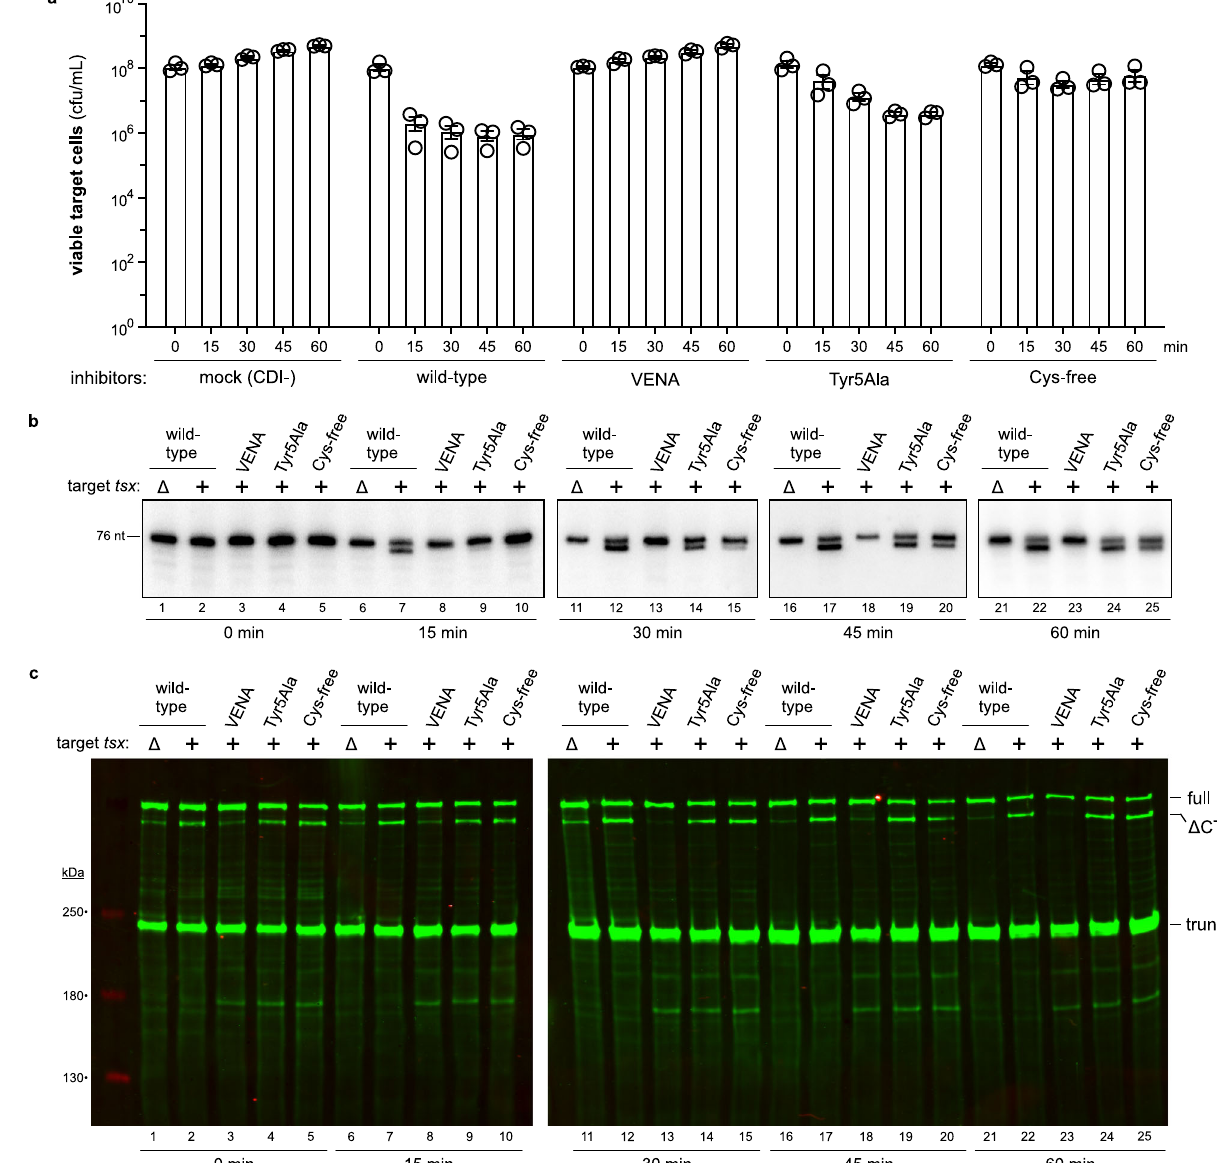
Fig.7|CdiA-CT EC3006 translocationduringcell-mediateddelivery.a Competition co-cultures.Targetbacteriaweremixedata1:1ratiowithinhibitorcellsthatdeploy theindicatedCdiA-CT EC3006 variants.Viabletargetcellswereenumeratedascolony- formingunits(cfu)permLevery15min.Presenteddataweretheaverage±SEMfor three independentexperiments. b In vivonuclease activity.TotalRNAwasisolated from the co-cultures in panel a for Northern blot analysis using a probe to tRNA Ile . c CdiA-CT EC3006 processing. Urea-soluble protein was isolated from the co-cultures